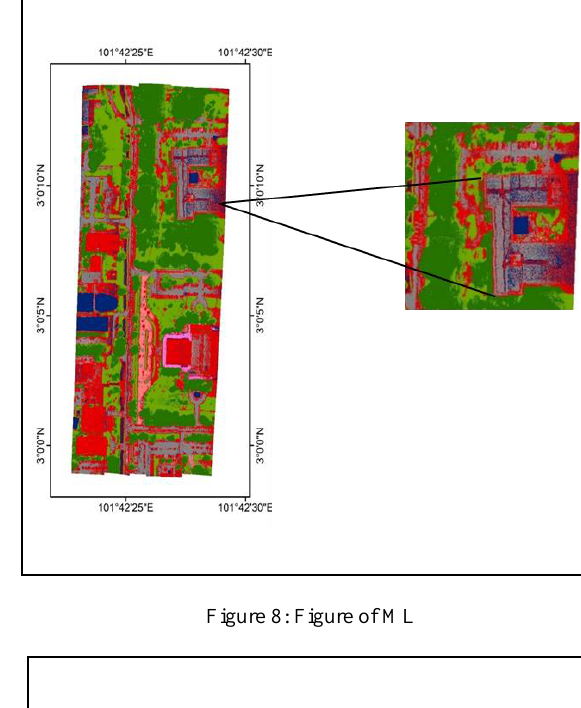
Figure 8: Figure of ML